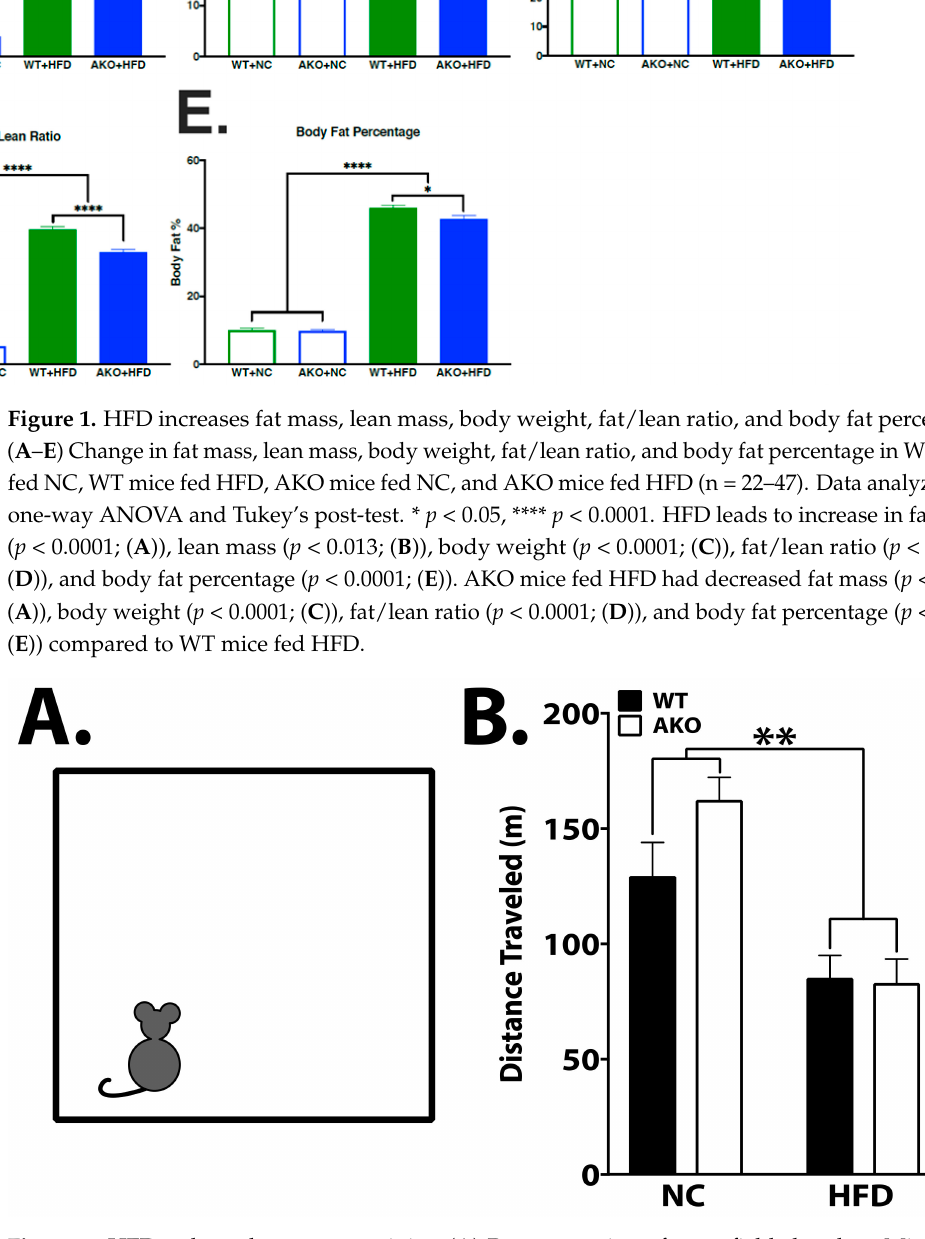
Figure 2. HFD reduces locomotor activity. ( A ) Representation of open field chamber. Mice were placed in a square chamber (27 cm × 27 cm) and allowed to explore freely for 2 h. ( B ) No difference was observed between genotypes, but total distance traveled was significantly reduced in HFD-fed mice ( p < 0.01). Data analyzed via one-way ANOVA and Tukey’s post-test. ** p <